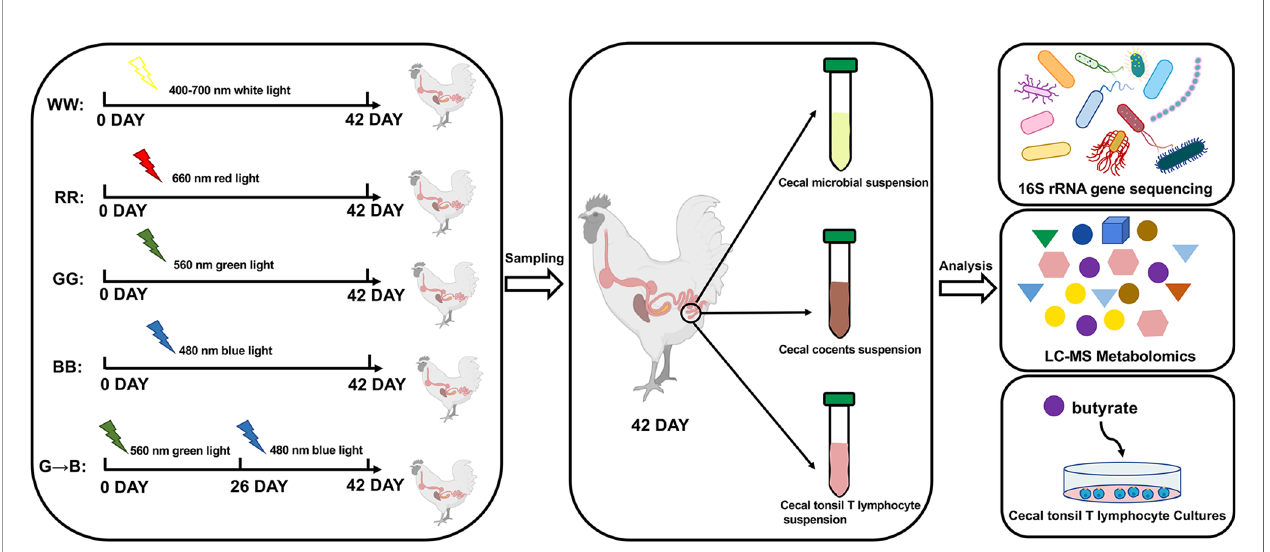
FIGURE 1 | An overview of the experiment design and sample collection. A total of 160 post-hatching day P0 Arbor Acre male chicks were randomly divided into four light treatment groups ( n = 40), including white light group (400 to 700 nm, WW), red light group (660 nm, RR), green light group (560 nm, GG), and blue light group (480 nm, BB) by a LED system. On P26 at 23:00, after the lights were turned off, 20 chickens from the green light treatment were transferred to the blue light treatment. The fi ve light groups were as follows: WW, RR, GG, BB, and G ! B. At P42, all chicks were euthanized, and then their cecum tissue and cecum content were harvested for microbial sequencing and metabolomics pro fi ling. In addition, T lymphocyte was obtained aseptically from cecal tonsil in G ! B. Then, a single-cell suspension was prepared with RPMI 1640 medium and then stimulated with butyrate to verify if exogenous butyrate promoted the proliferation of T lymphocytes in vitro